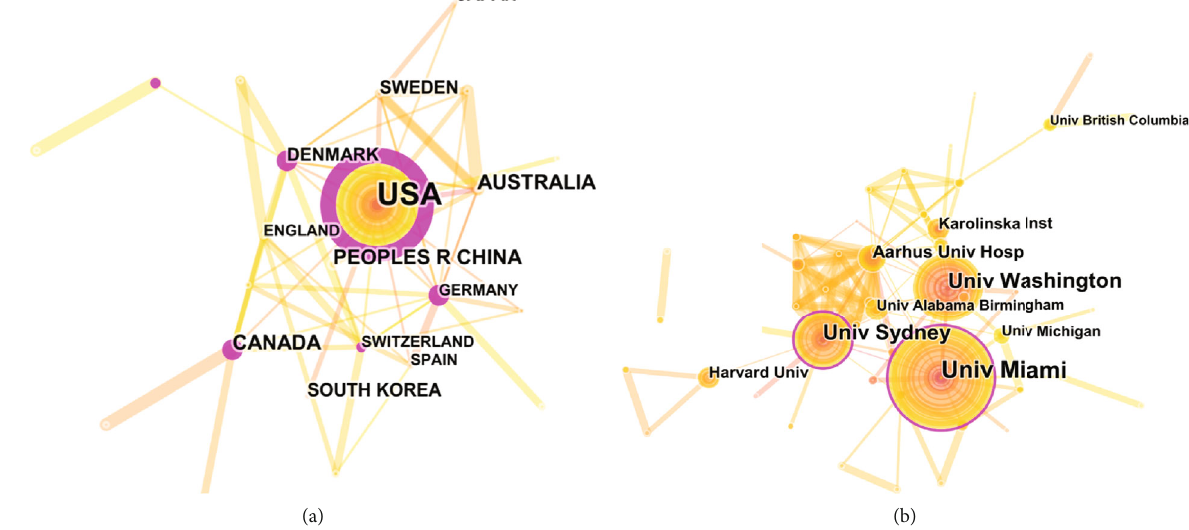
Figure 7: The analysis of countries and institutions. (a) Network map of countries/territories engaged in pain after spinal cord injury. (b) Network map of institutions engaged in pain after spinal cord injury.